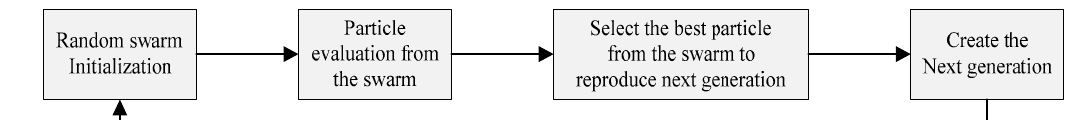
Figure 2. General process of particle swarm optimization (PSO).